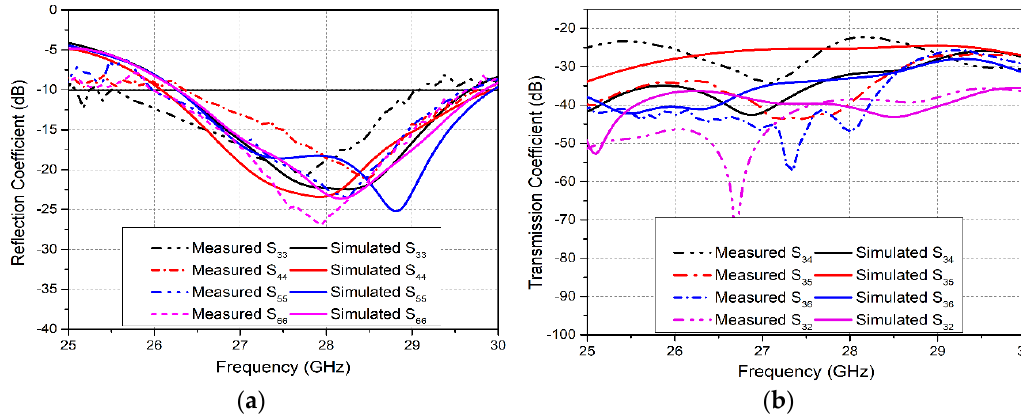
Figure 10. Simulated and Measured S-parameter plots for 5G MIMO Antennas: ( a ) Reflection Coefficient Curves; ( b ) Transmission Coefficient Curves.